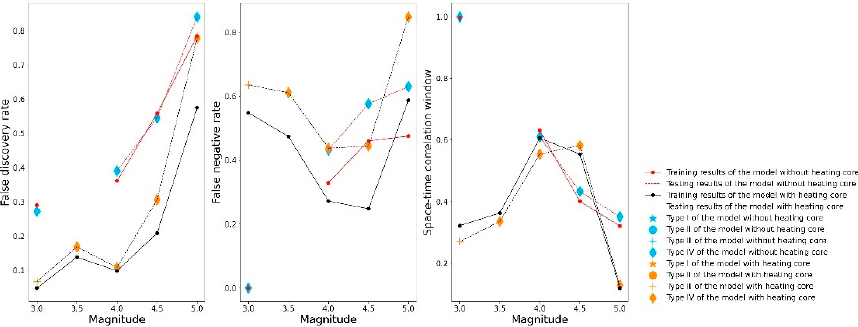
Figure 10. Comparison of the training and test results of the optimal models with and without a “heating core” at different magnitudes when the moving window size is 50.